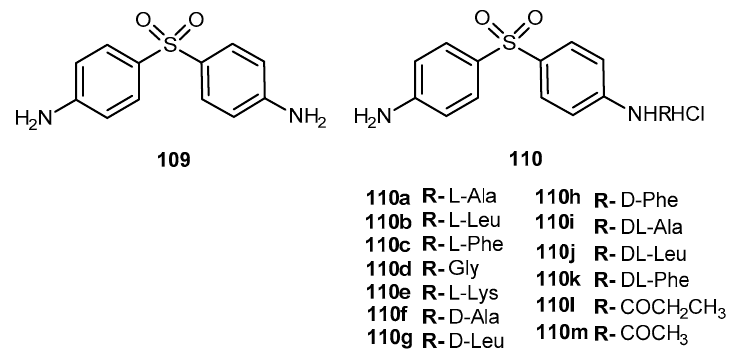
Figure 46. Structures of dapsone ( 109 ) and its amino acid amines derivatives ( 110a – m ).